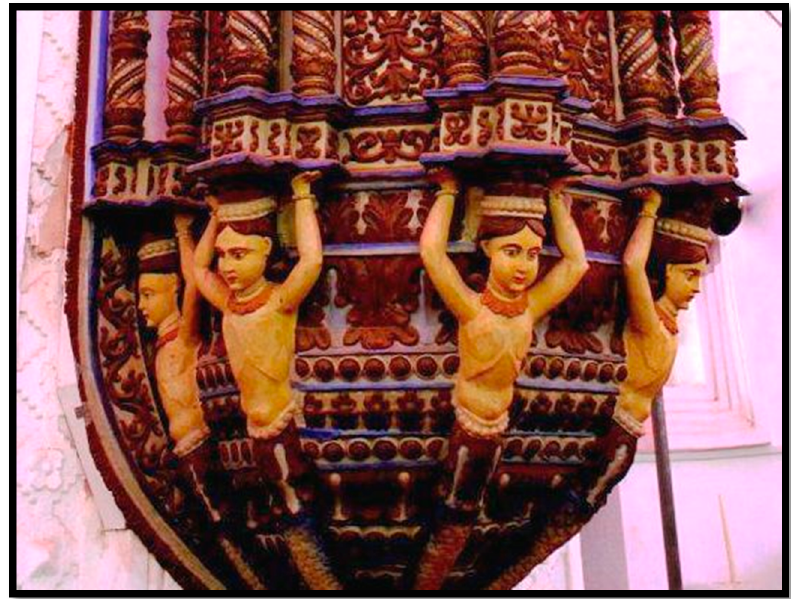
Figure 11. Teak pulpits from the Igreja de Nossa Senhora do Monte in Velha Goa, 1710 Casa-Museu Medeiros e Almeida, Lisbon and the Santana Church (Saint Anne), 17th century, Talaulim, Goa.